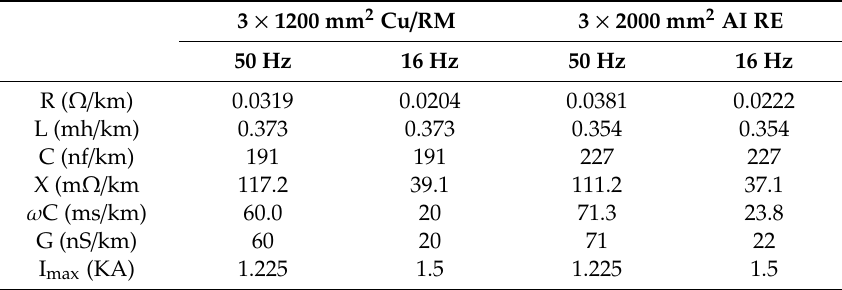
Table 3. Cable parameter, 50 Hz vs. 16 Hz.